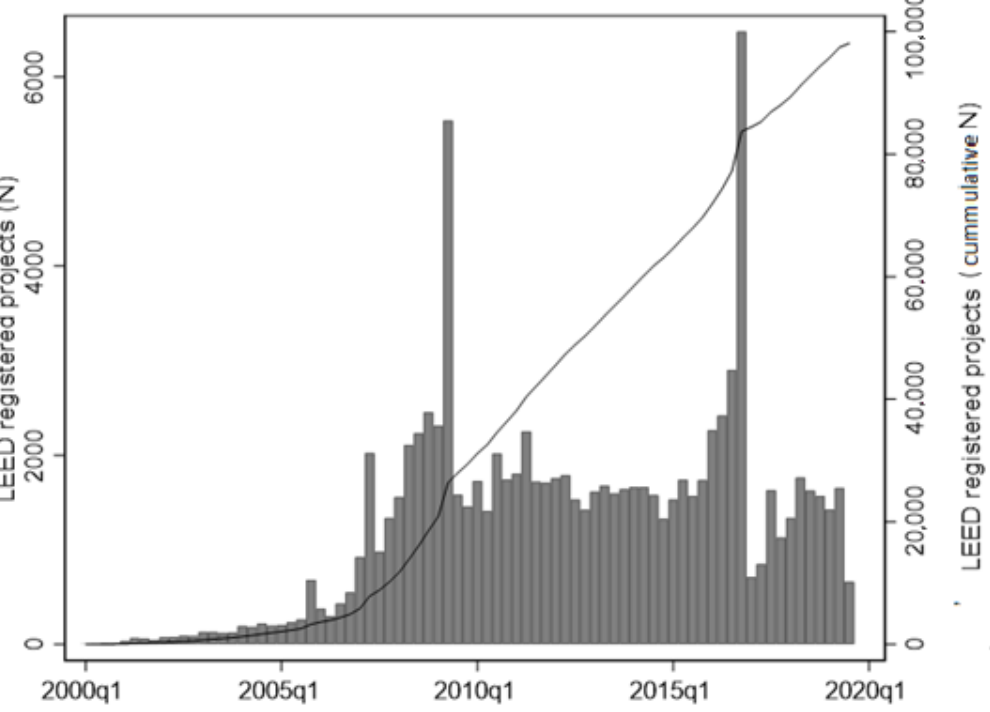
Figure 1. Global dynamics of project registration in LEED from 1q 2000 to 1q 2020 (quarterly).